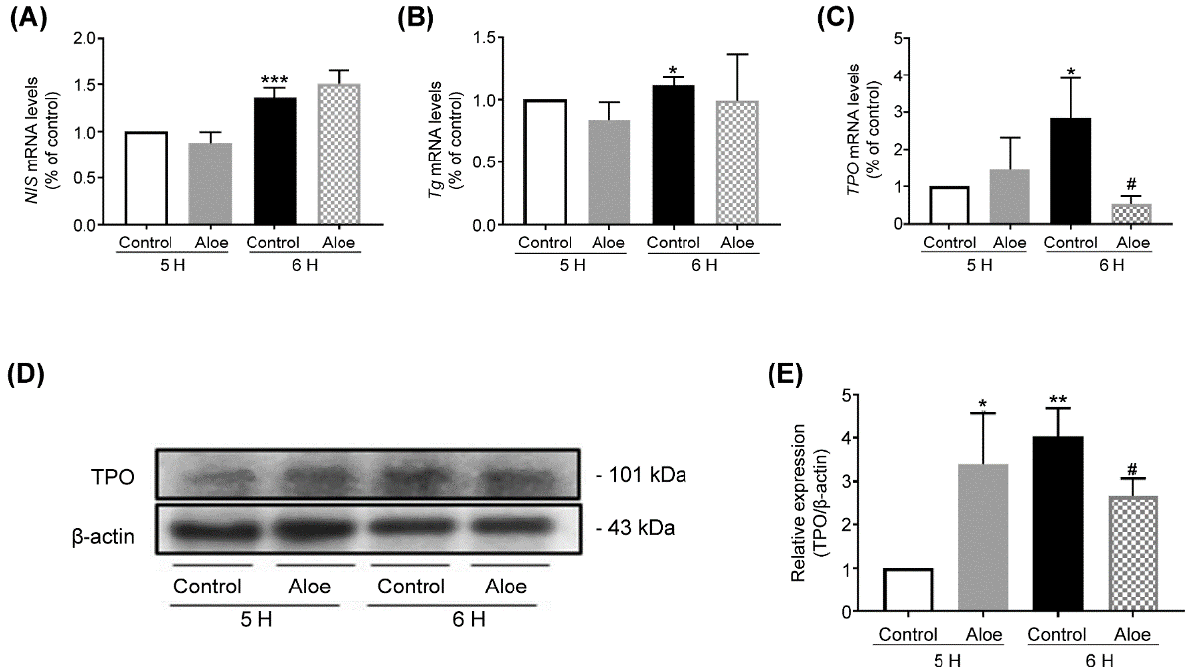
Figure 3. Effects of Aloe (AV) on the expression of factors involved in thyroid hormone synthesis and release by mRNA and protein level in FRTL-5 cells. ( A – C ) Cells were treated with 10 µ g/mL AV in both 5H and 6H media conditions, and mRNA expression of NIS, TG, and TPO were measured. * p < 0.05, *** p < 0.001 versus 5H control; # p < 0.05 versus 6H control. ( D ) Cells were treated with 10 µ g/mL AV in both 5H and 6H media conditions, and protein expression of TPO were measured. ( E ) Densitometric analysis of TPO. Data were represented as means ± SD ( n = 3); * p < 0.05, ** p < 0.01 versus 5H control; # p < 0.05 versus 6H control.